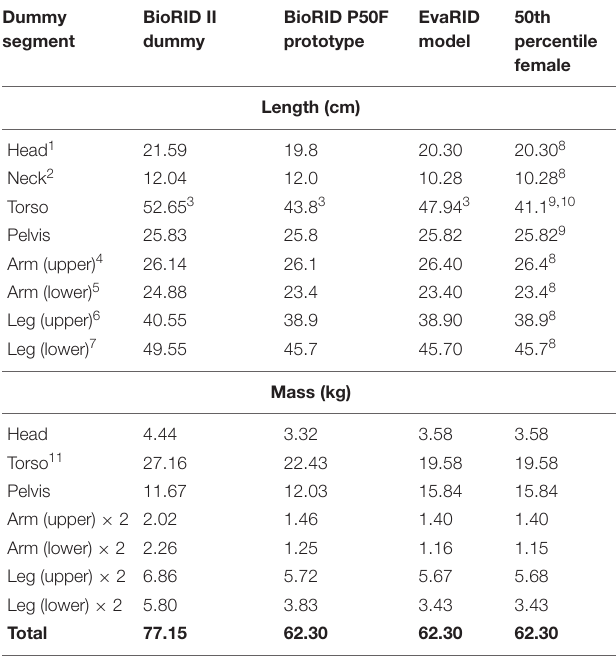
TABLE 1 | The length and mass of each body segment of the BioRID II, BioRID P50F, EvaRID model, and the 50th percentile female.